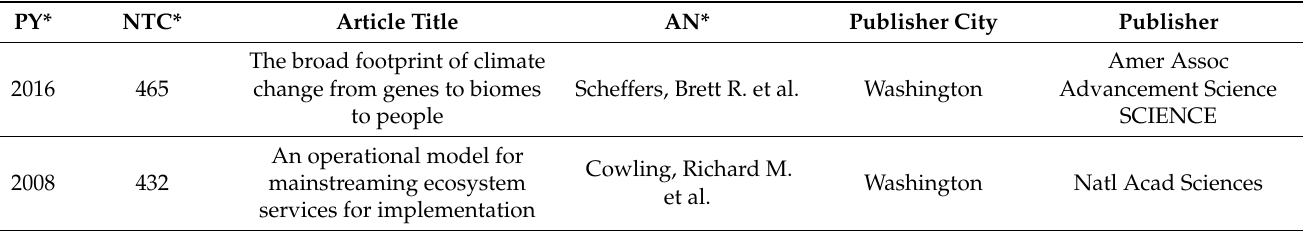
Table 6. Top 10 most cited articles from 1996 to